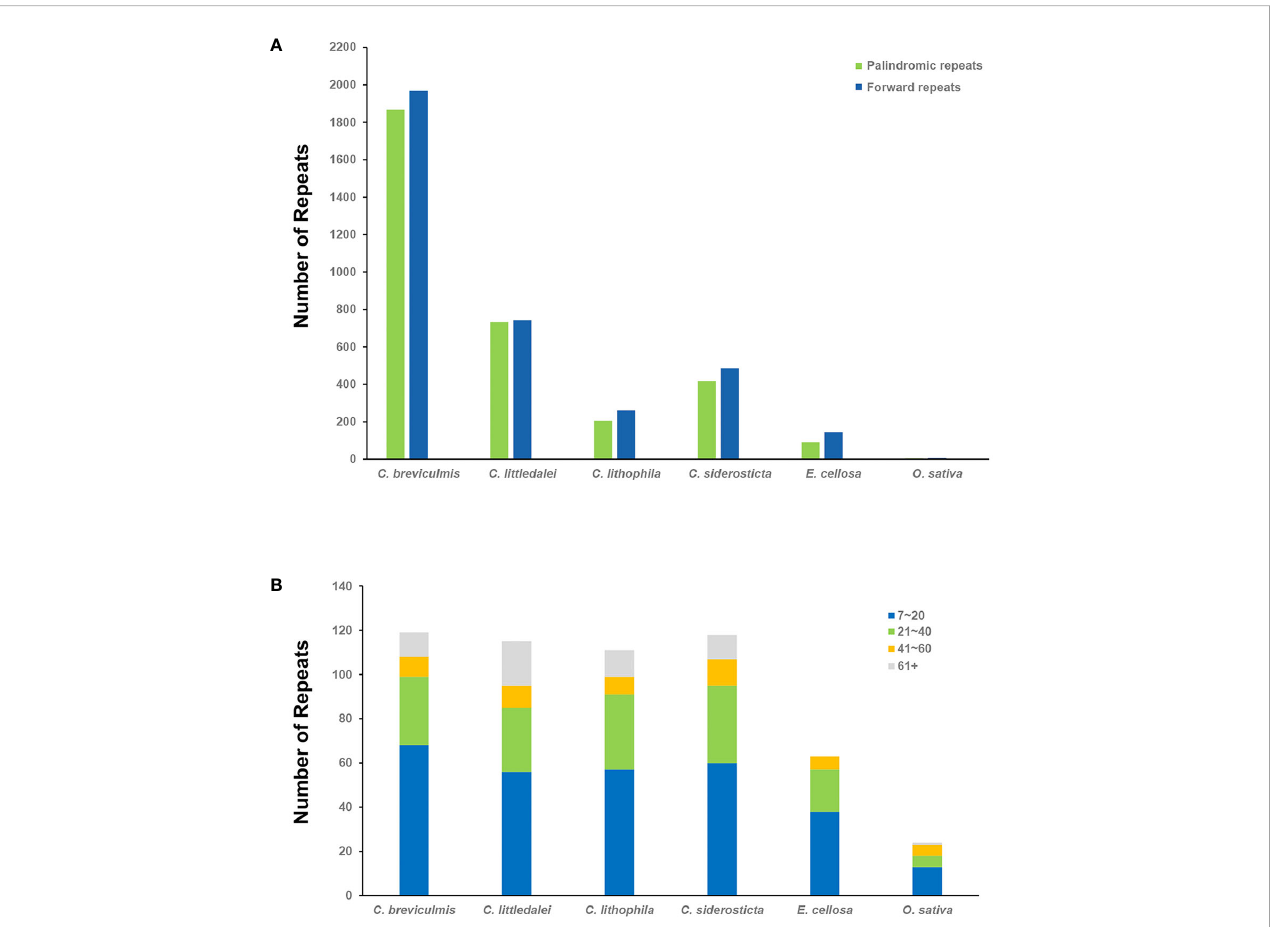
FIGURE 2 Statistics of repeats in the four chloroplast genomes of Carex and its relatives. (A) The number of different dispersal repeats in six chloroplast genomes using the REPuter program. P, Palindromic, F, Forward; (B) The number of tandem repeat rearrangements in the six chloroplast genomes and the proportion of their length